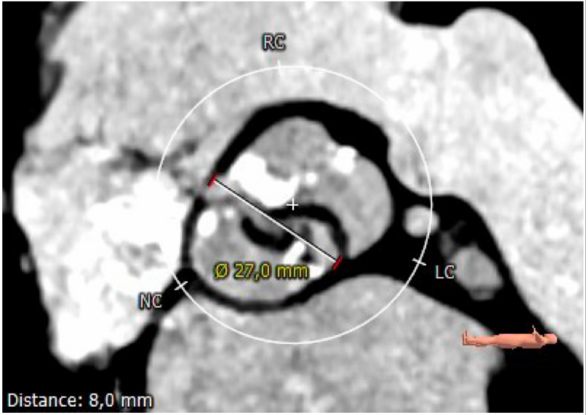
Figure 5. CT image of bicuspid